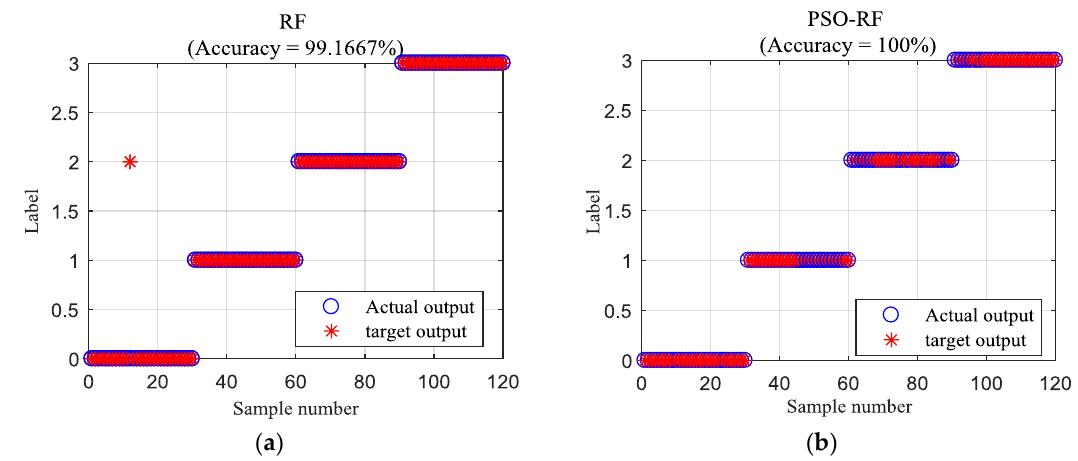
Figure 11. Identification results of: ( a ) random forest (RF); ( b ) particle swarm optimization-random forest (PSO-RF).